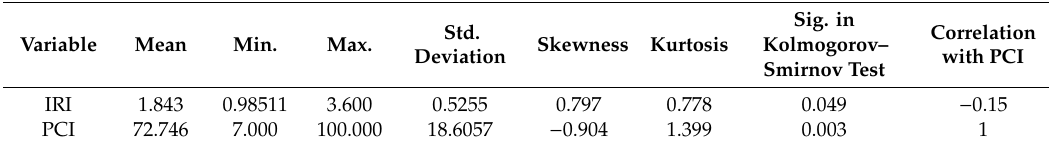
Table 7. Statistical characteristics of the utilized